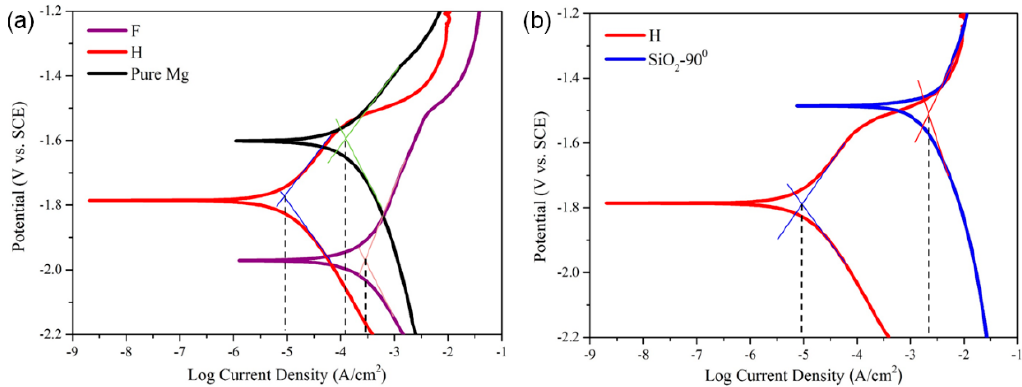
Figure 14. Potentiodynamic polarization curve of XK105. ( a ) Comparison of XK105-F, XK105-H, and pure Mg and ( b ) comparison of XK105-H before and after erosion test by SiO 2 particles with erosion angle of 90°.